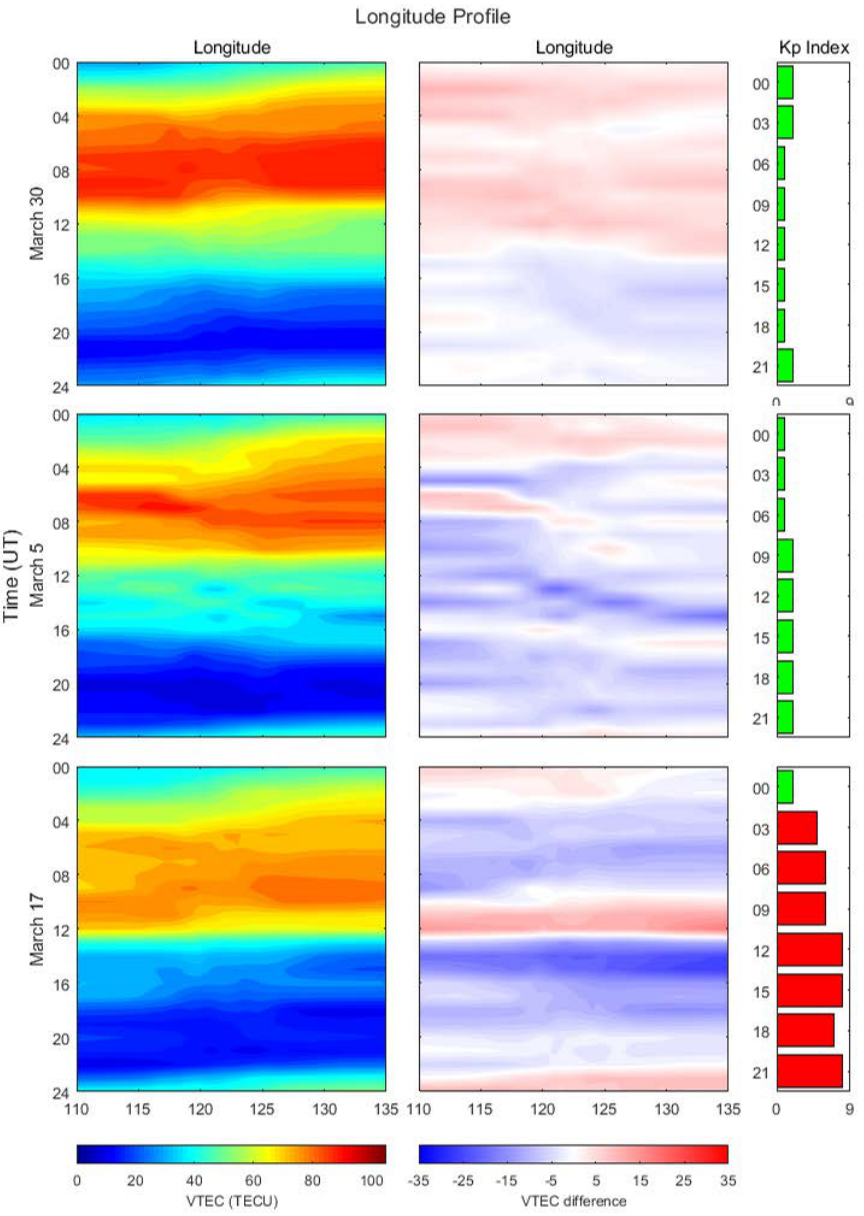
Figure 14. Longitude profiles of 30 March, 5 March and 17 March with the difference between them and the latitude profiles of quiet day VTEC plus Kp-index bar graph.